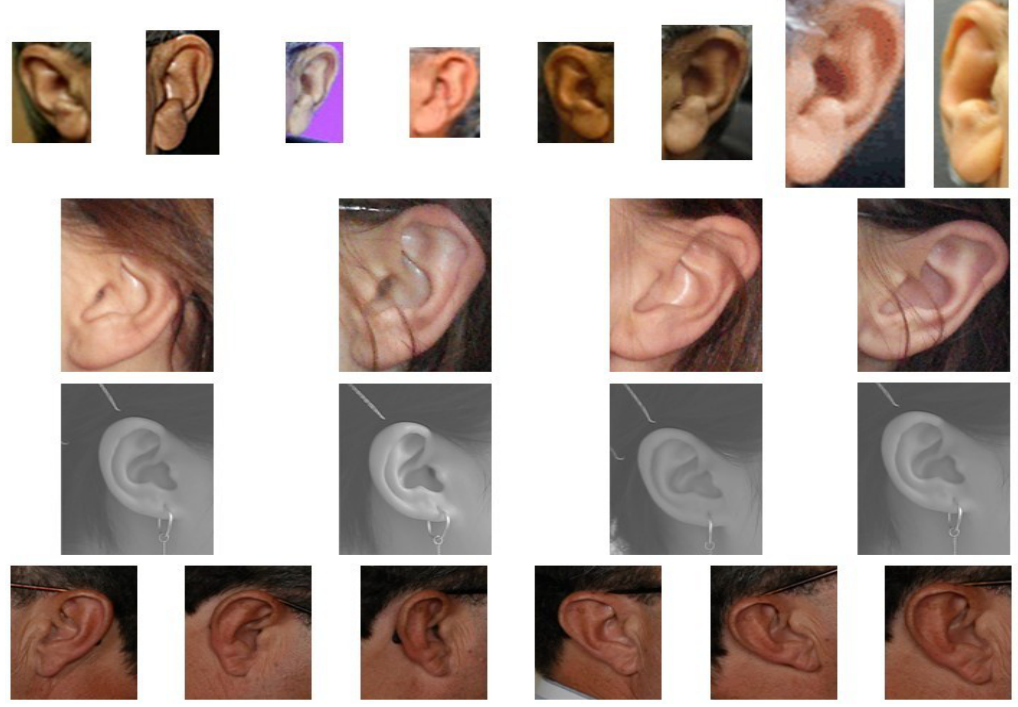
Figure 3. Original ear images for one subject from AWE (first row), WPUT (second row), USTB II (third row), and AMI (fourth row).